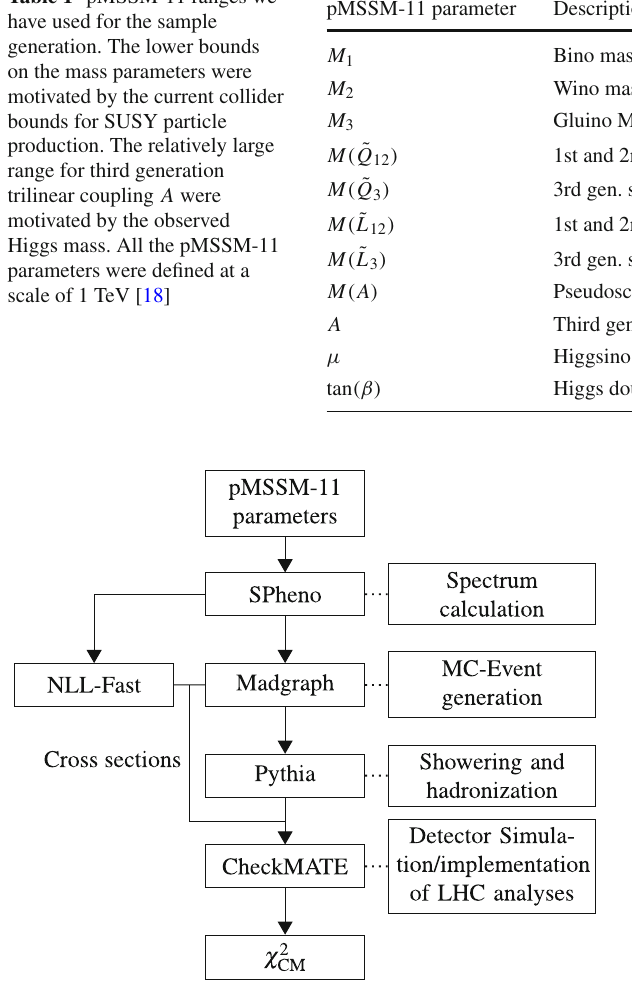
Fig. 2 Flow chart of the simulation chain we have used in the sample generation. The subscript “CM” in χ 2 using